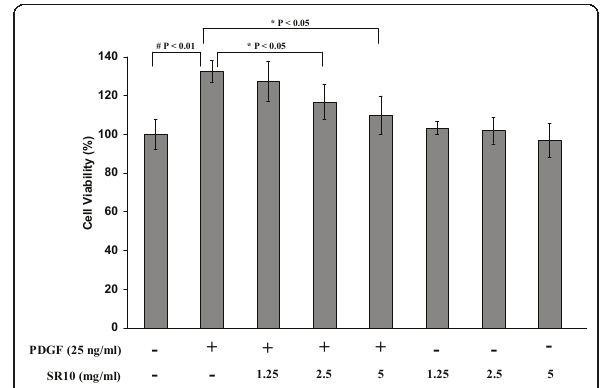
Figure 3 Effect of SR10 on PDGF-BB-stimulated proliferation of A7r5 cells . Cells were incubated with PDGF-BB (25 ng/ml) for 24 hours in the absence or presence of various concentrations of SR10. Cells incubated with various concentrations of SR10 without PDGF- BB were used to indicate the cytotoxicity of SR10. After 24 hours, MTT assay was performed to measure the cell viability in different treatments. Percentage of cell viability without treatment of PDGF- BB or SR10 was set as 100% (negative control). Percentage of cell viability of other treatment groups was calculated against negative control. Data are expressed as mean ± S.D. with eight replicates for each of three independent experiments. By Mann-Whitney test, significant difference when compared to PDGF-BB alone was indicated by *p < 0.05 or # p < 0.01. 3 H-thymidine incorporation into DNA but the increase was inhibited by co-treatment of SR10 in a concentra- tion-dependent manner (Figure 4).